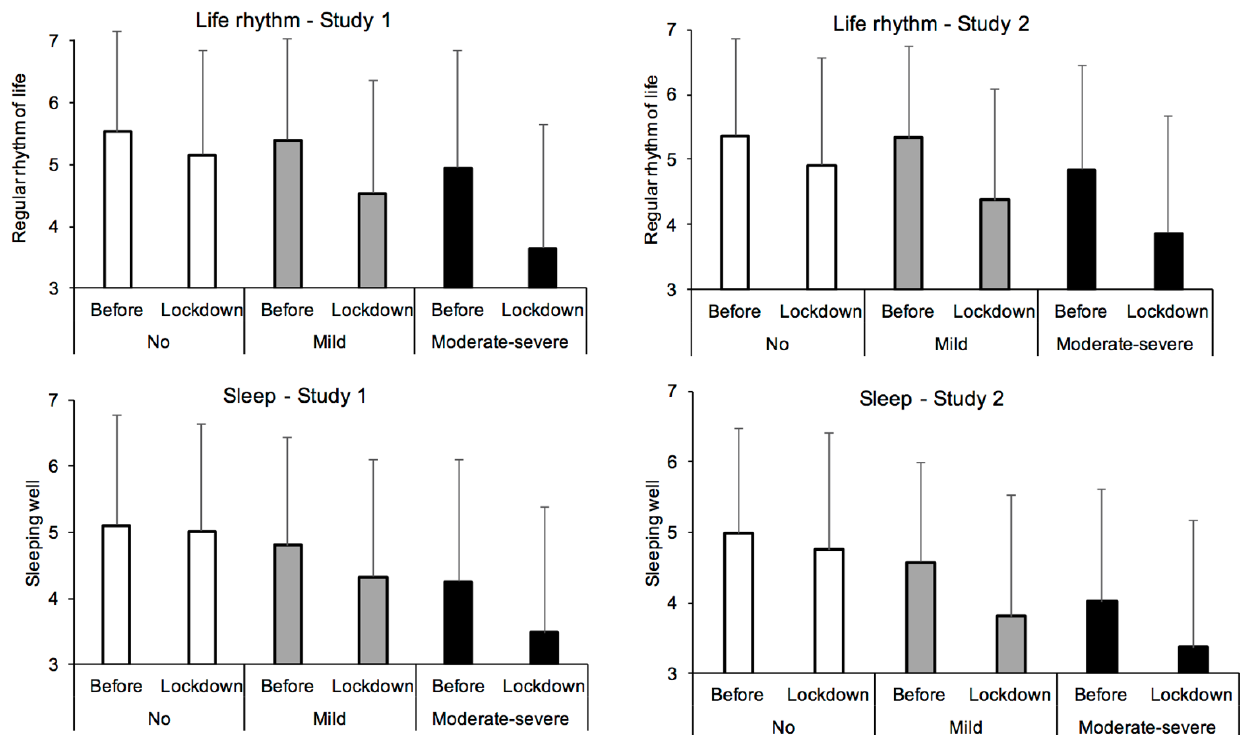
Figure 4. Quality of sleep and of life rhythm as a function of severity of depressive symptoms in Study 1 and Study 2. The reported consumption of sleeping pills and anxiolytics, F(1, 1172) = 7.17, p = 0.01,